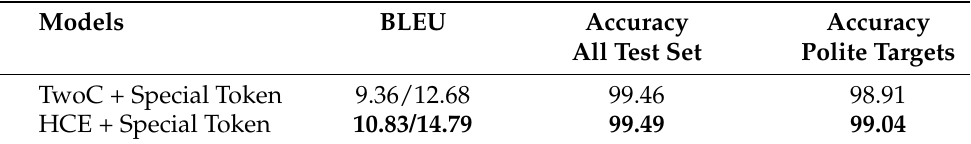
Table 3. English-Korean BLEU scores (normal/tokenized) and accuracy (%) of honorifics for models with explicit control of honorifics by special tokens on the input. All the models are forced to obtain the translation with the honorific style of the reference sentence.